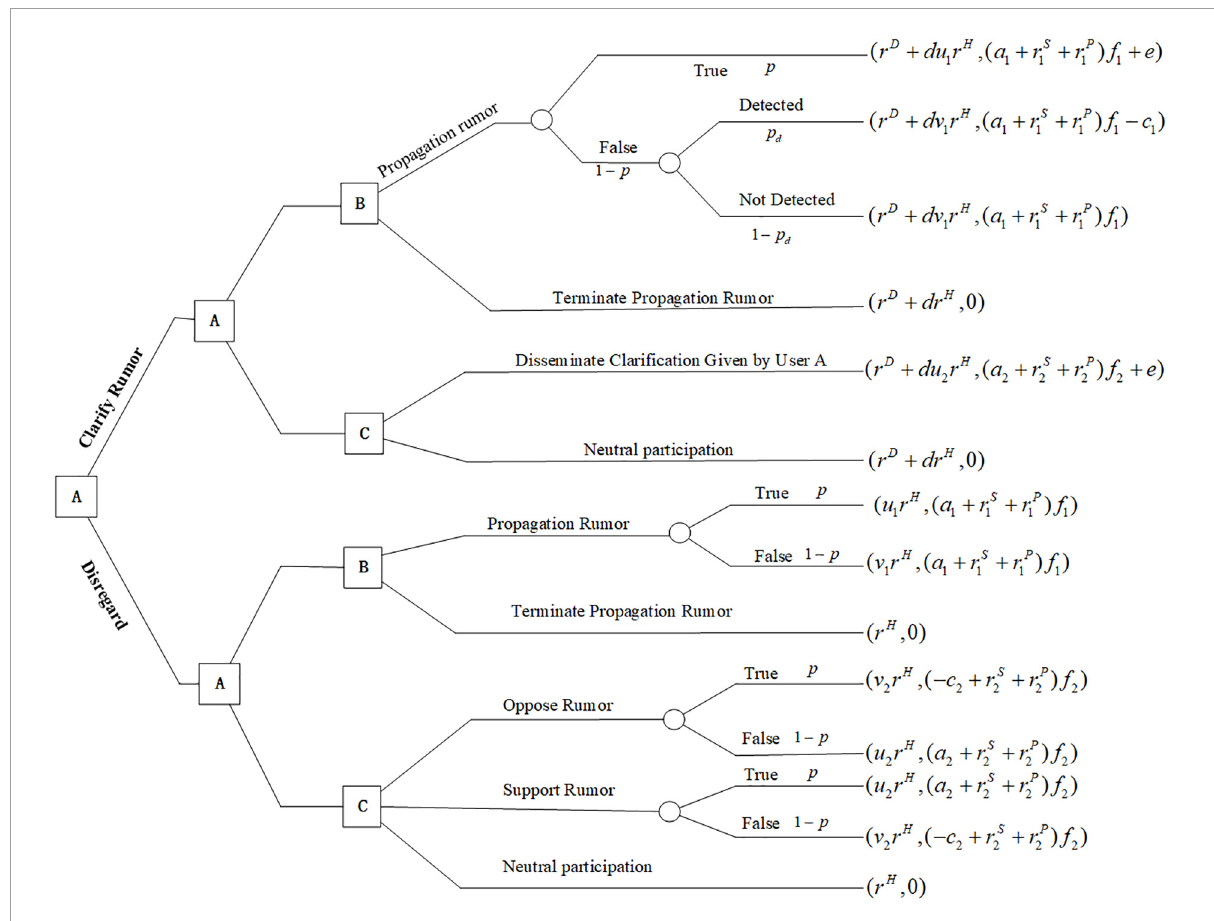
FIGURE1 The sequence of moves of players in a rumor clarification and propagation